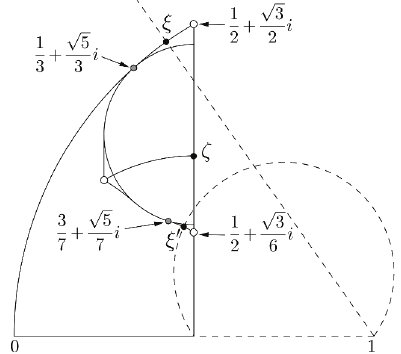
Figure 16. Point ξ is the highest one on the ray and point ξ 0 is its image on the